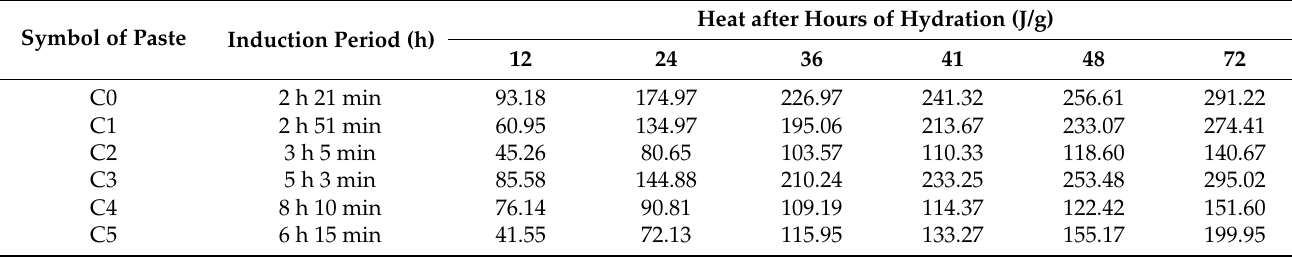
Figure 9. Total heat evolved as a function of time for all pastes used in the study. Table 10. Heat of hydration of